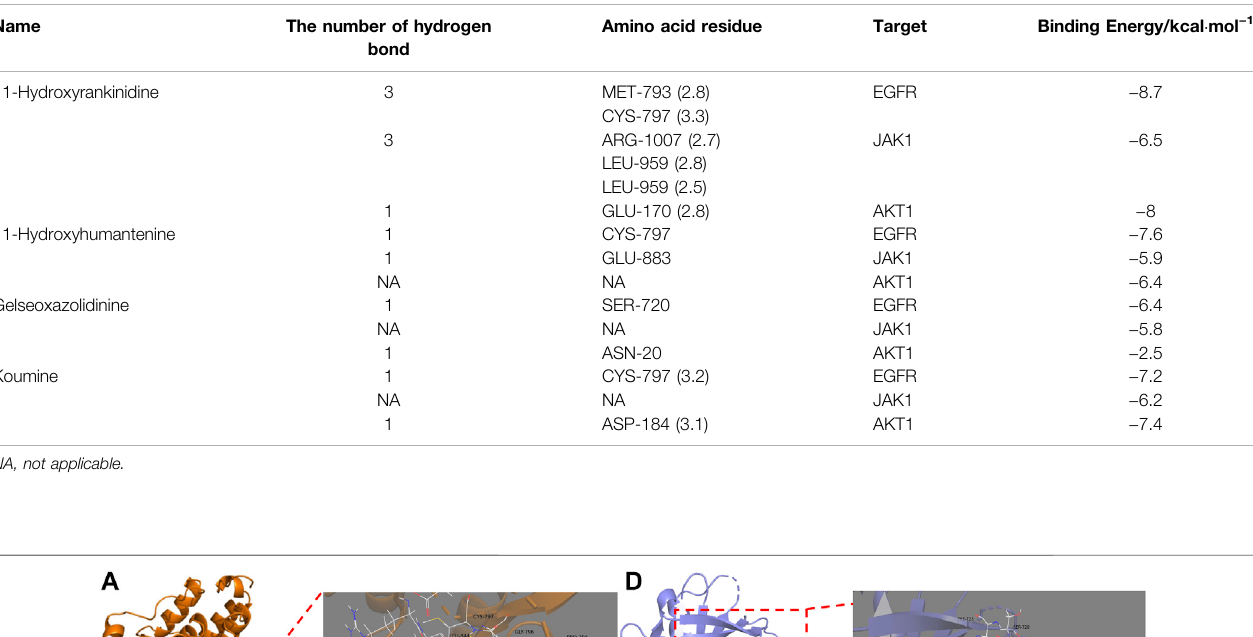
TABLE 3 | Virtual molecular docking of active ingredients of GEB and